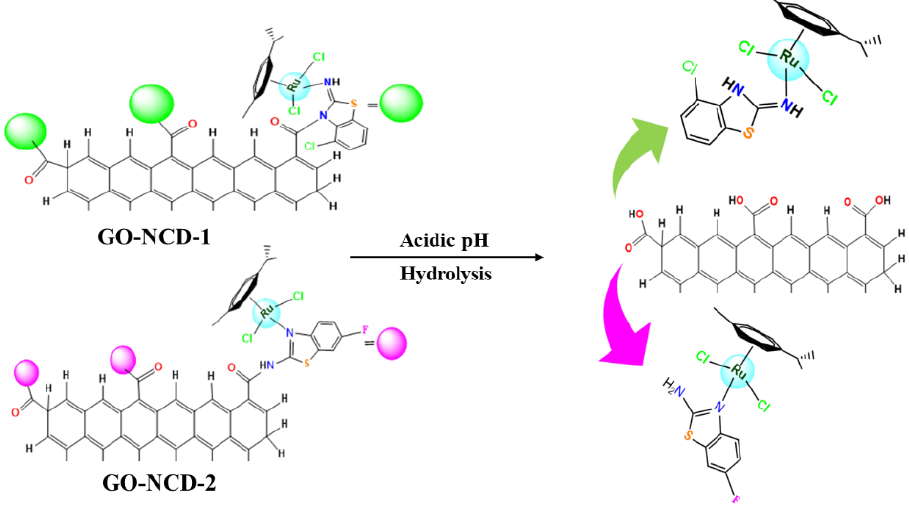
Figure 16. Proposed drug release mechanism.